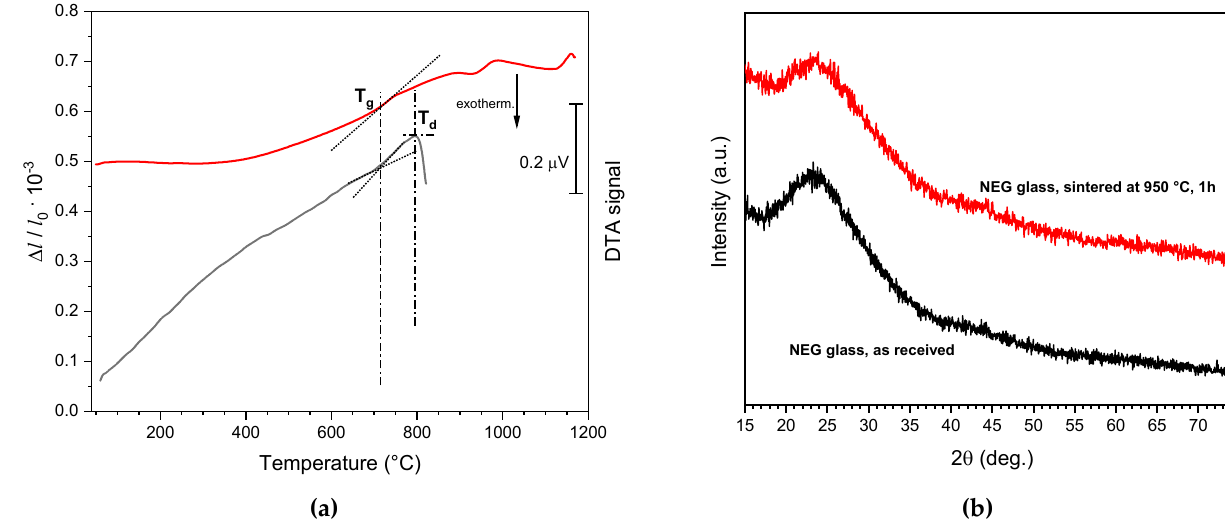
Figure 2. ( a ) DTA and dilatometry plots of the studied LCD glass; ( b ) X-ray diffraction analysis of LCD glass in the as-received state and after sintering at 950 ◦ C (5 ◦ C/min heating rate, 1 h holding